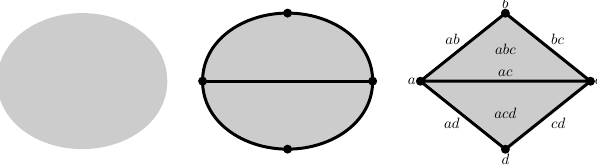
Figure 1. From continuous space to combinatorial space through